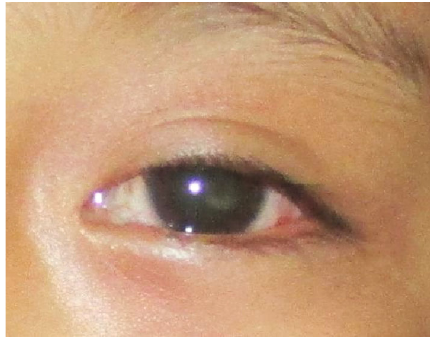
Figure 1: Presence of congestion and leukocoria in the left eye.